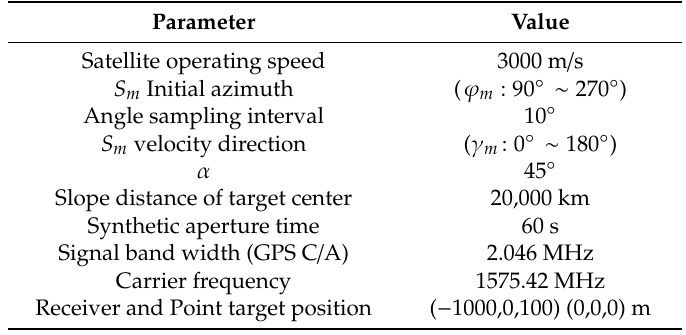
Table 1. Simulation parameters.